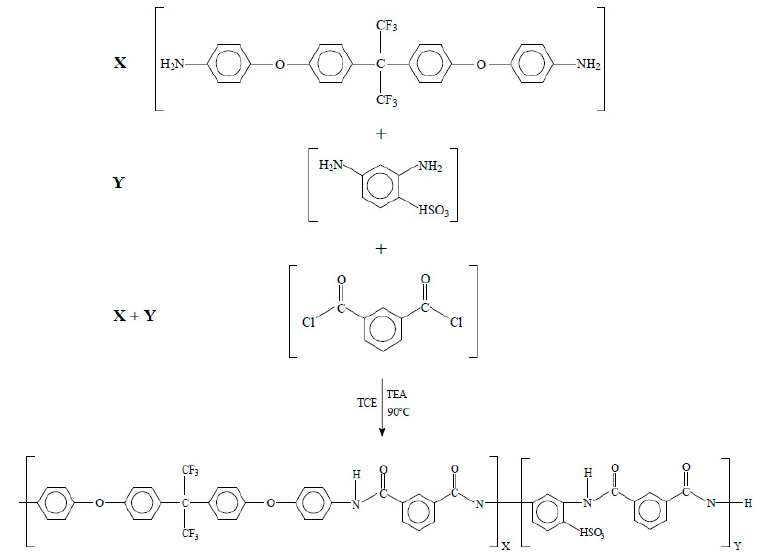
Figure 1. Schematic of polycondensation reaction for synthesis of HFDA/ISO polyamide ( X = 100 mol %, Y = 0 mol %) and sulfonated copolyamides HFDA/DABS/ISO ( X = 95, 90, 80, 70, 60, and 50 mol %).